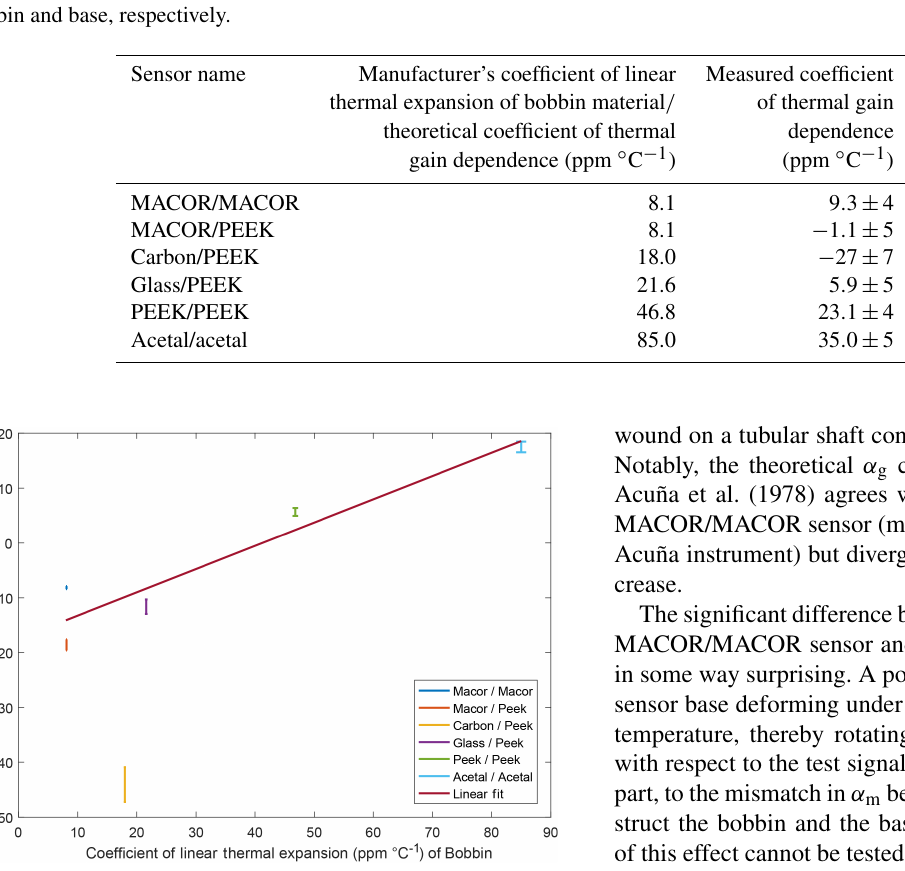
Figure 16. The measured coefficient of thermal gain depen- dence, α g , for each sensor is approximately proportional to the manufacturer-specified coefficient of linear thermal expansion of the bobbin material, α m . Robust linear regression of the points gives a slope of 0 . 42 ± 0 . 09 and an offset of − 17 ± 4ppm ◦ C − 1 . The data for carbon/PEEK are considered unreliable and were not included in the calculation of the trend